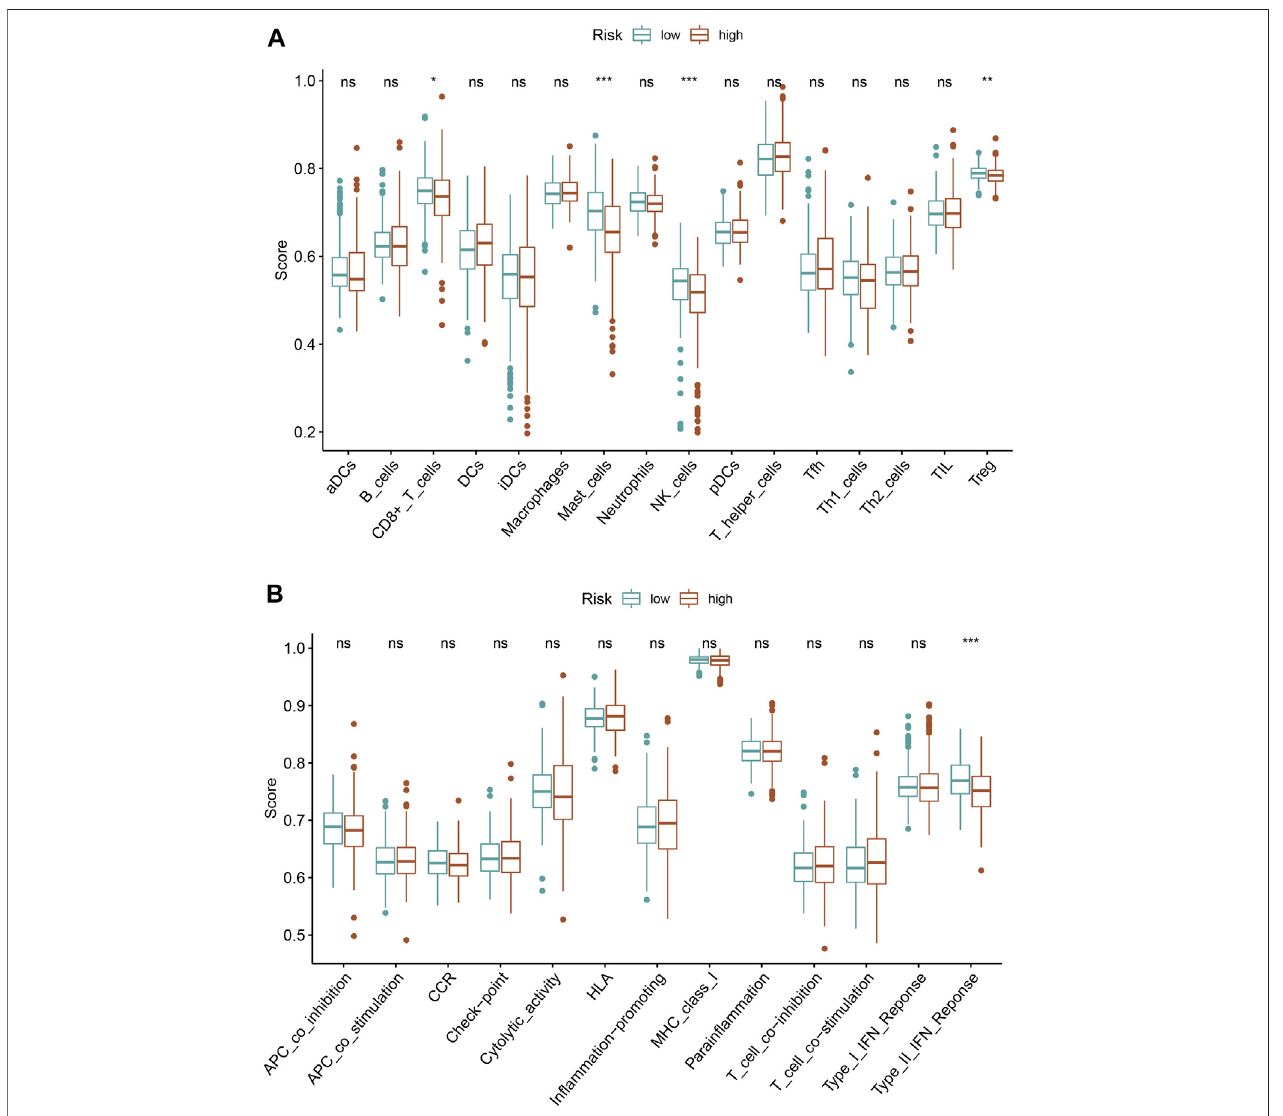
FIGURE 8 | Association of the ferroptosis-based signature with immune in fi ltrating cells (A) , immune function activity (B) .